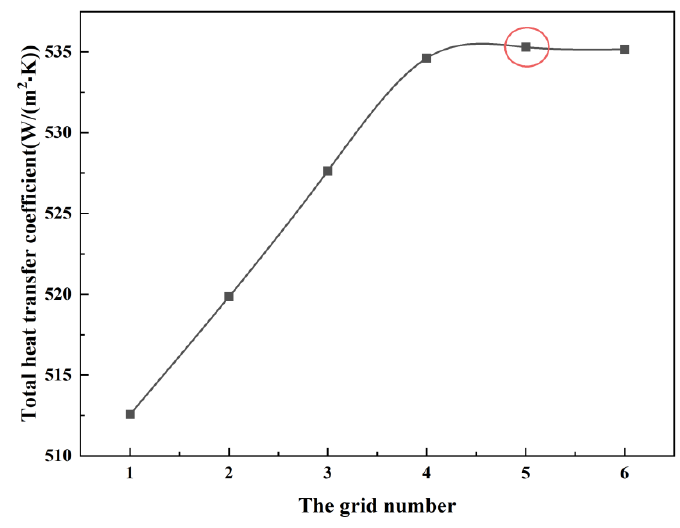
Figure 6. Grid independence for PCHE.